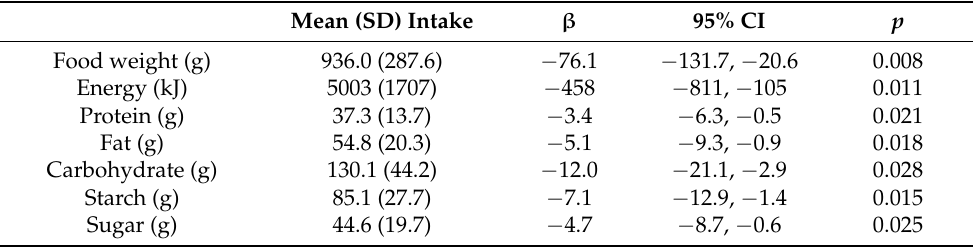
Table 5. Mean intakes of food, energy and macronutrients during the ad libitum buffet lunch and their associations with carbohydrate taste detection